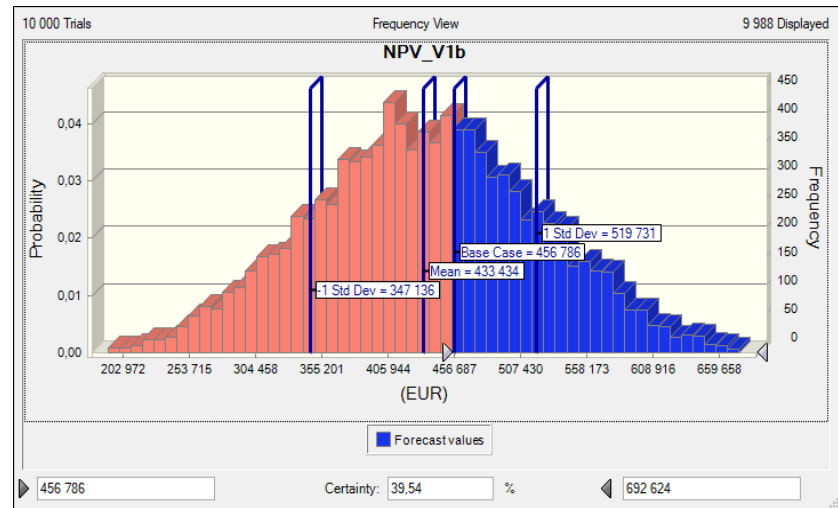
Figure 9. Probability distribution of NPV_V1b.